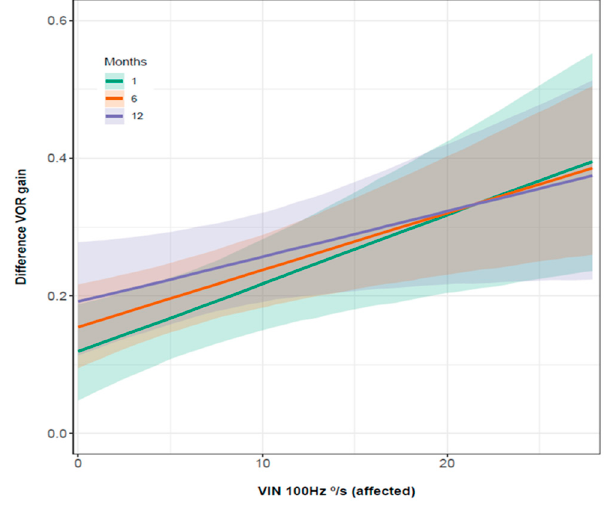
Figure 5. Association between VOR gain difference and SPV of SVIN. Vertical axis: VOR gain difference. Horizontal axis: SPV of SVIN at 100 Hz (in the ear affected). Green line: one month after episode of VN. Orange line: six months after episode of VN. Purple line: twelve months after episode of VN. We can observe that the difference of VOR gain and the SPV of SVIN at 100 Hz decrease as over time.